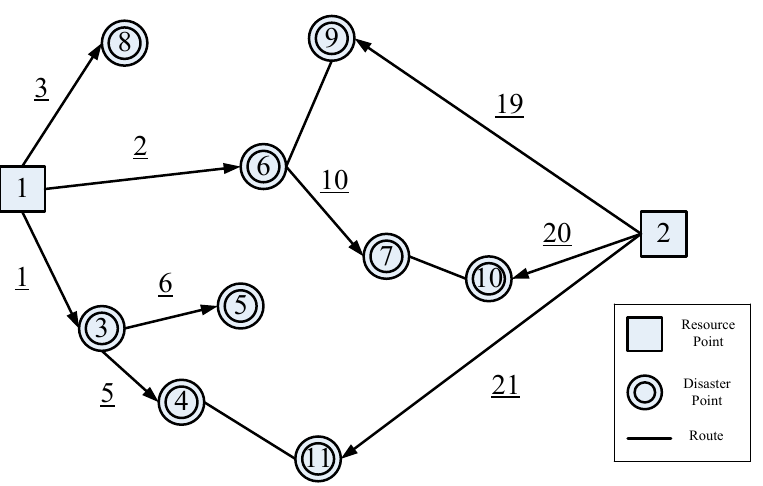
Figure 9. Diagram of the repair process after new resource point is added (Case 2).